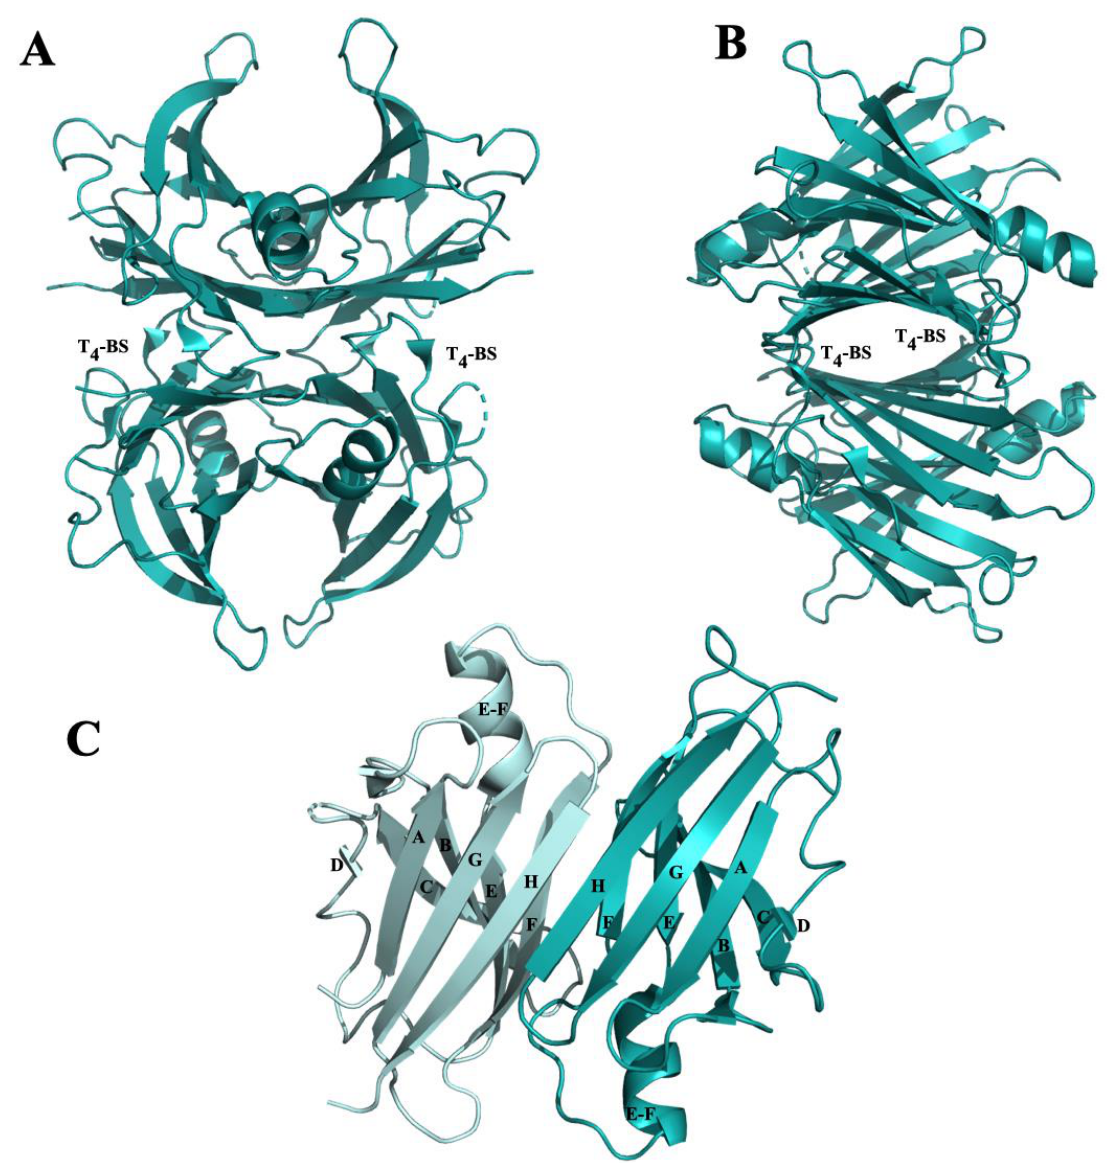
Figure 2. Graphic representation of TTR tetramer. ( A ) The TTR tetramer composed by four equal monomers assembled by 222 molecular symmetry. The tetramer is crossed by thyroxin binding pockets (T4-BP). ( B ) The TTR tetramer rotated of 90 ◦ . ( C ) Representation of the dimer composed by two identical monomers. Each monomer is composed by strands D, A, G H, C, B, E and F, and a short EF α-helix.